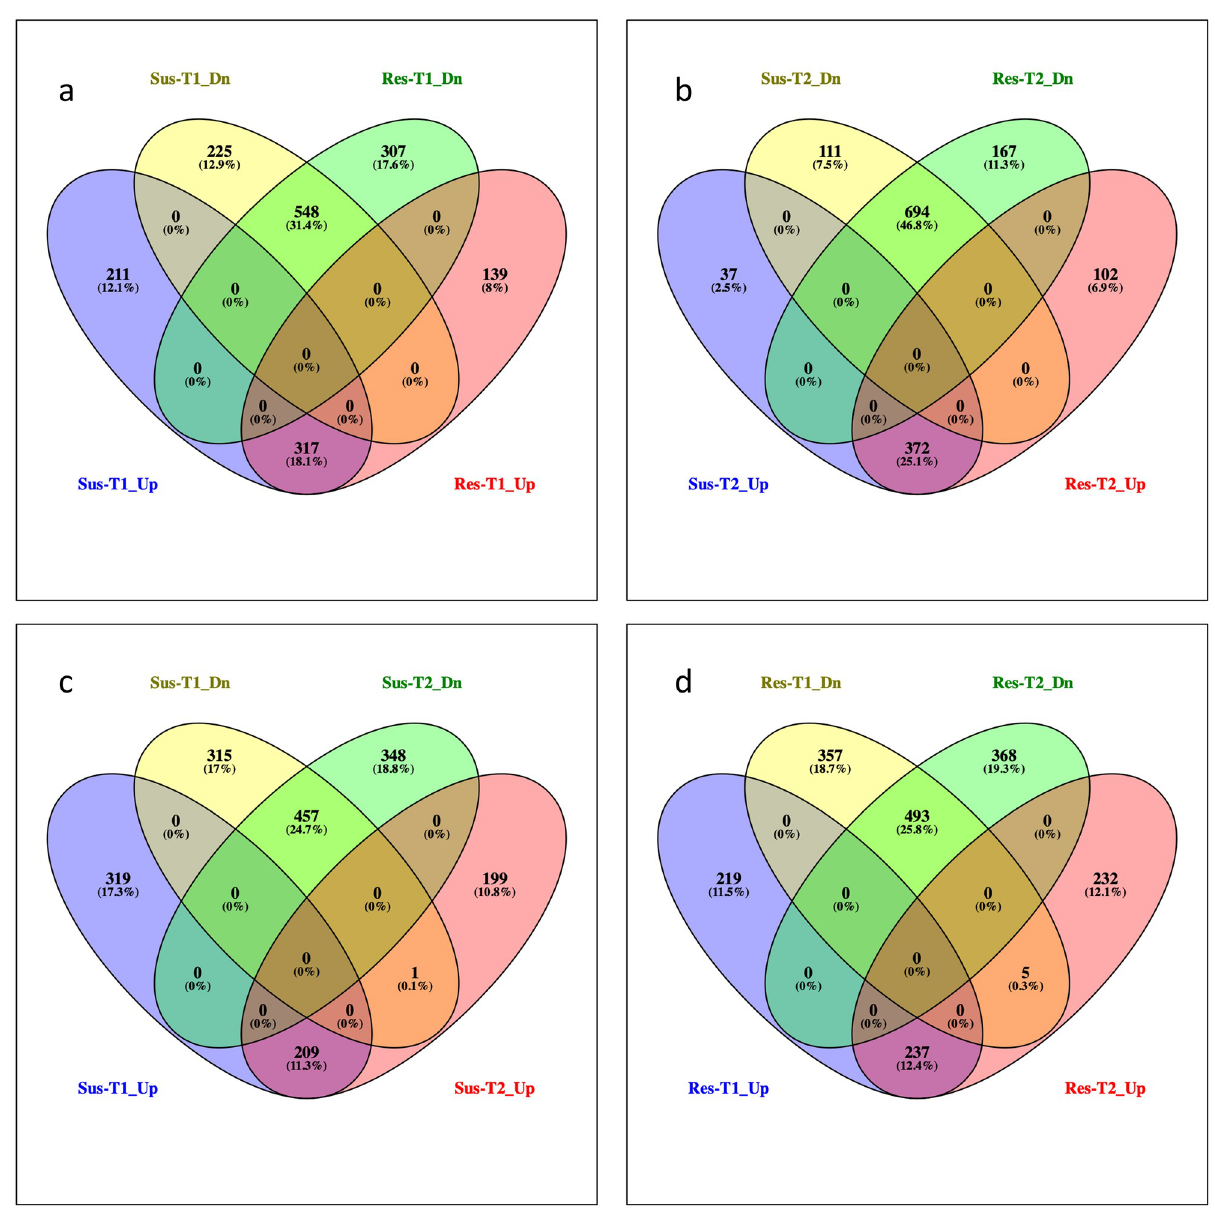
Fig 3. Venn diagrams showing differentially expressed Sclerotinia sclerotiorum genes during interaction with canola. Venn diagram shows the number of common and unique genes at (a) T1 and (b) T2, between up and down regulated gene sets of NEP32 and NEP63. (c) and (d) shows the comparison of up and down regulated genes at T1 and T2 gene sets of NEP32 and NEP63, respectively.